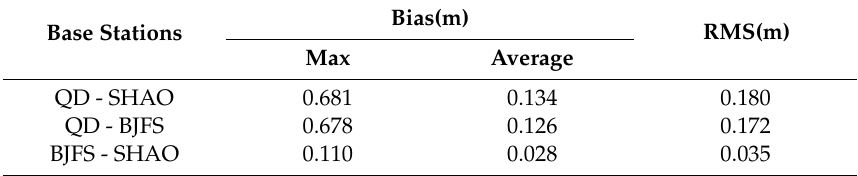
Figure 11. The instantaneous sea level comparation of the DD method using three different base stations. ( a ) Shows IGS stations BJFS, SHAO and our reference station QD, ( b ) shows the three DD results without outlies of the instantaneous sea level with different base stations. Table 4. Cross-validation of DD instantaneous sea level using three different base stations.